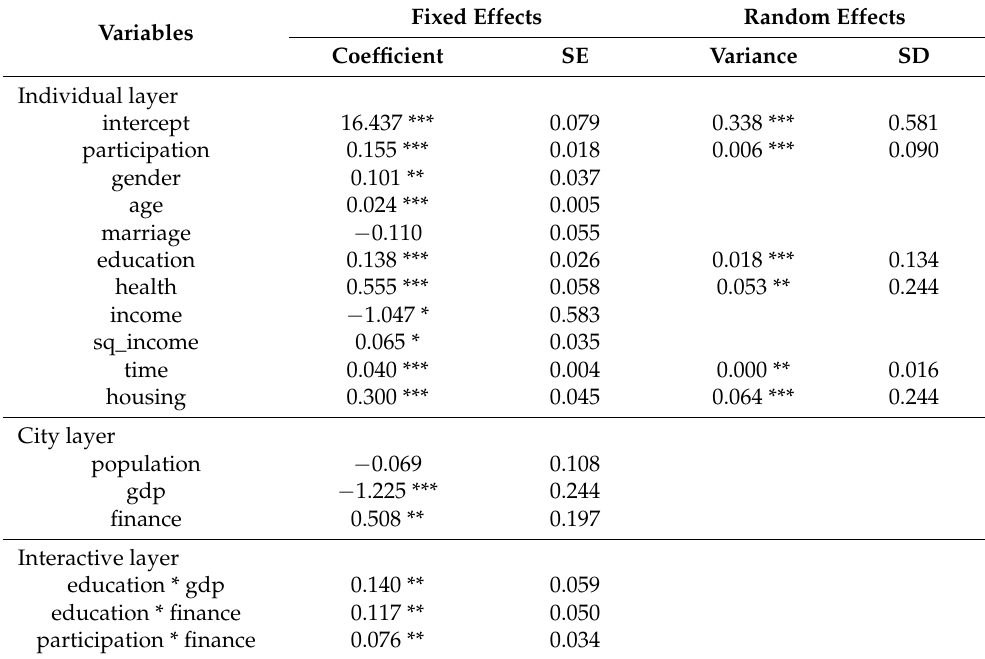
Table 5. Results of mixed effects model on the influencing factors of the perceived social integration new urban